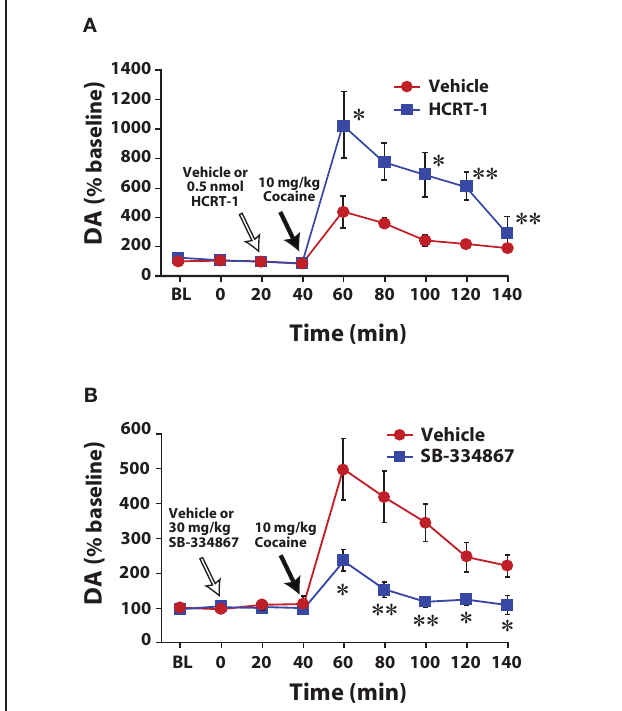
FIGURE 2 | Hypocretin manipulations influence cocaine-induced elevations in extracellular dopamine within the NAc core. (A) Shown are the mean ± SEM of extracellular levels of dopamine (DA) within the NAc core following intra-VTA infusion of vehicle ( n = 6) or 0.5nmol hypocretin-1 (HCRT-1; n = 6). (B) Shown are the mean ± SEM of extracellular levels of dopamine (DA) within the NAc core following i.p. injection of vehicle ( n = 6) or 30mg/kg SB-334867 ( n = 6). ∗ P < 0 . 05, ∗∗ P < 0 . 01 relative to vehicle. Modified from España et al. (2010,